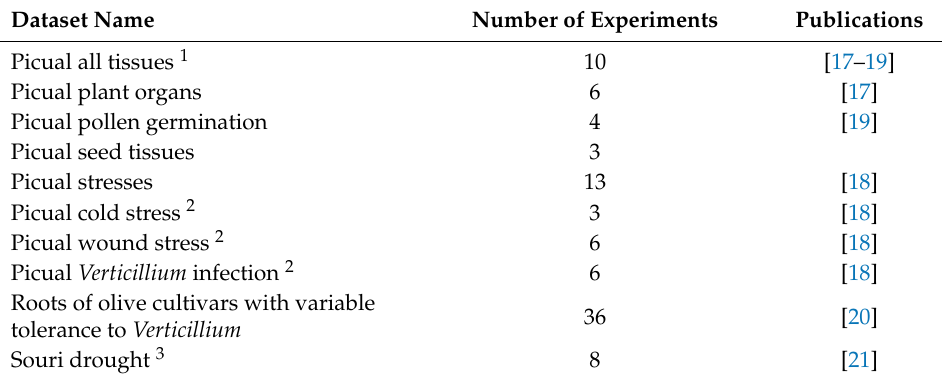
Table 1. Available expression datasets in